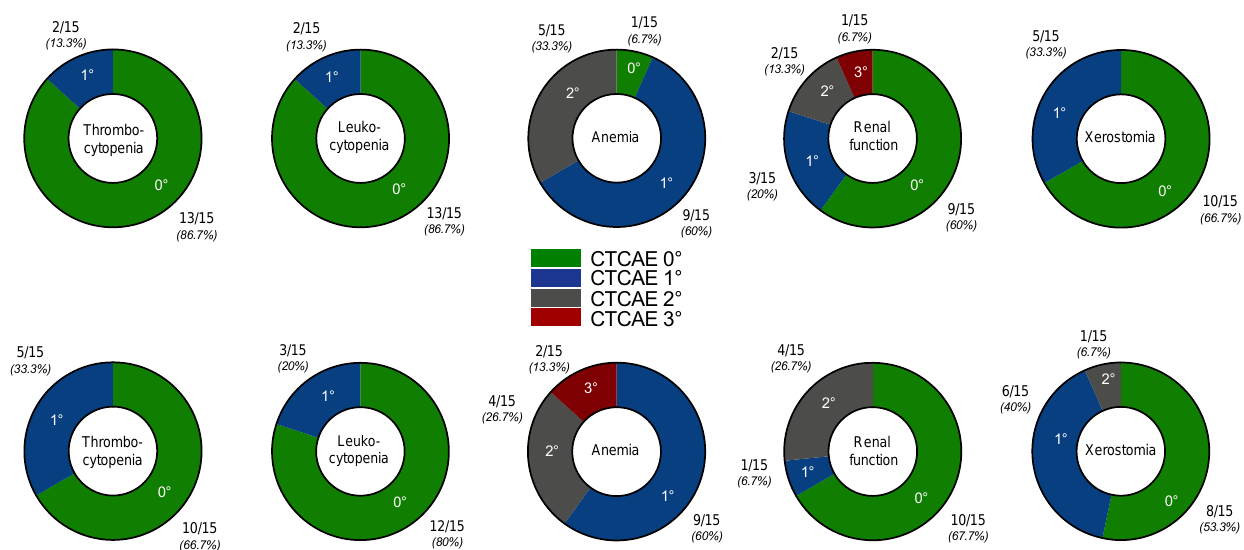
Figure 4. Graphical illustration of CTCAE grades for thrombocytopenia, leukocytopenia, anemia, renal function impairment and xerostomia at baseline (upper row) and after two cycles of [ 177 Lu]Lu-PSMA-617 RLT with at least one [ 225 Ac]Ac-PSMA-617 augmentation (lower row).